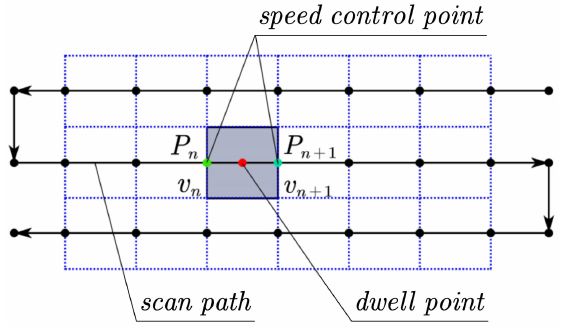
Figure 3. The speed residence method to control residence